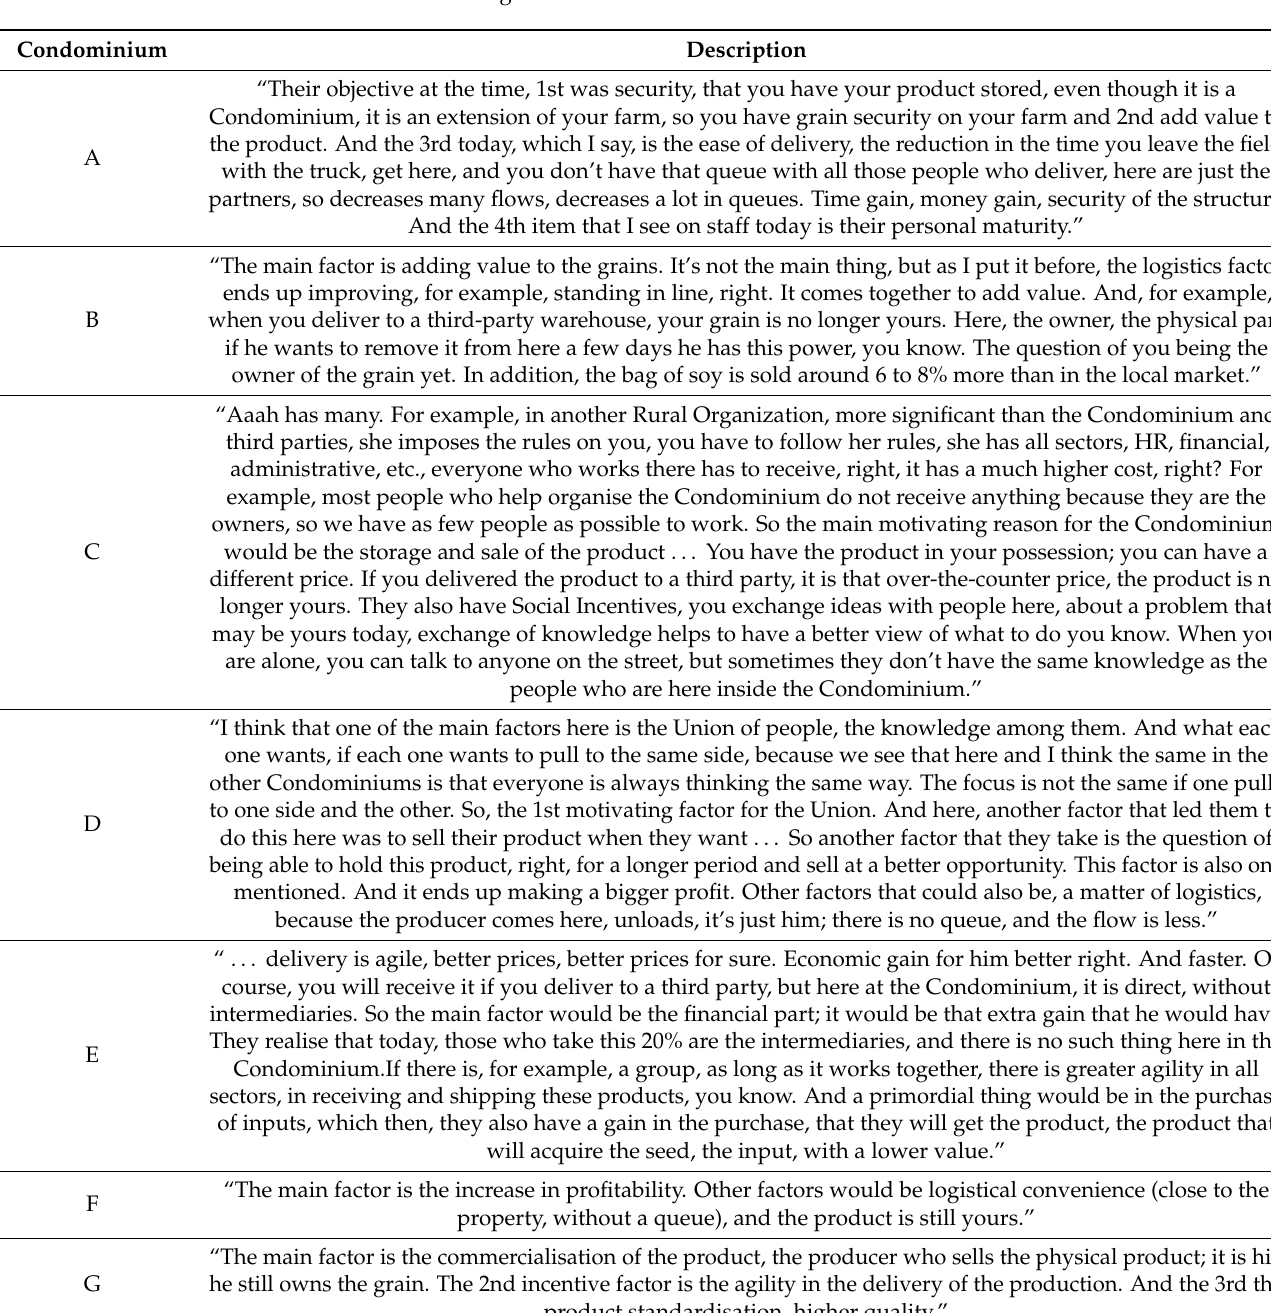
Table 6. Motivating Factors for Condominiums of Rural